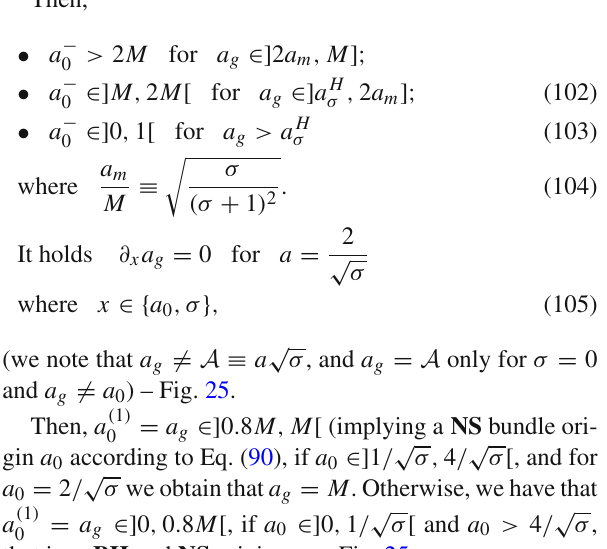
resent bundles with equal tangent spin a g and origin a 0 , consequently, ( a ) or with different planes σ and eventually different frequencies ω + g H ω − ( a ) – see Eq. (21). The origins are related to the frequencies and g √ H σ) , it follows for two bundles planes σ = 16 planes by a 0 = 1 /(ω b p a 4 0 σ √ √ /ω = σ/ σ or σ = σ p with frequencies related by ω p b p . This is √ b √ /ω = σ/ σ also related to bundle frequency ratios s = ω p b p . Based b upon the analysis of Eq.